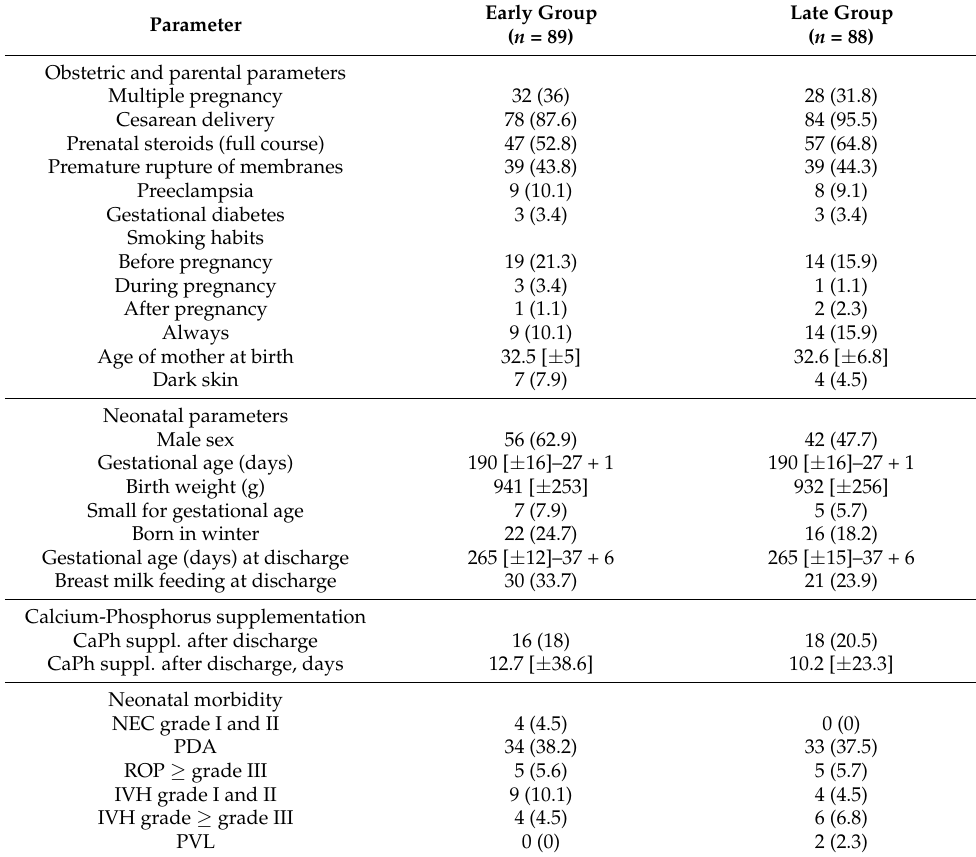
Table 1. Baseline characteristics and neonatal